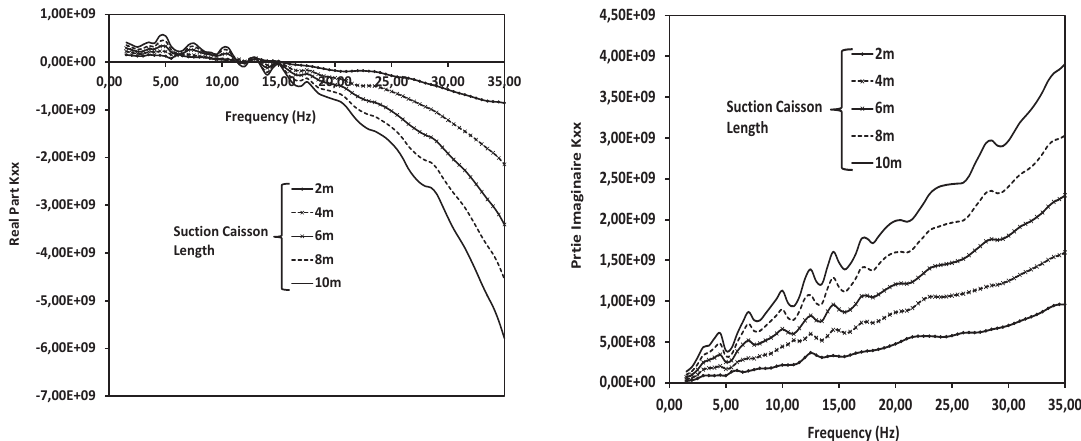
Figure 10: Variation of the vertical dynamic impedance as a function of the suction caisson length. Vertical and horizontal dynamic response of suction caisson foundations